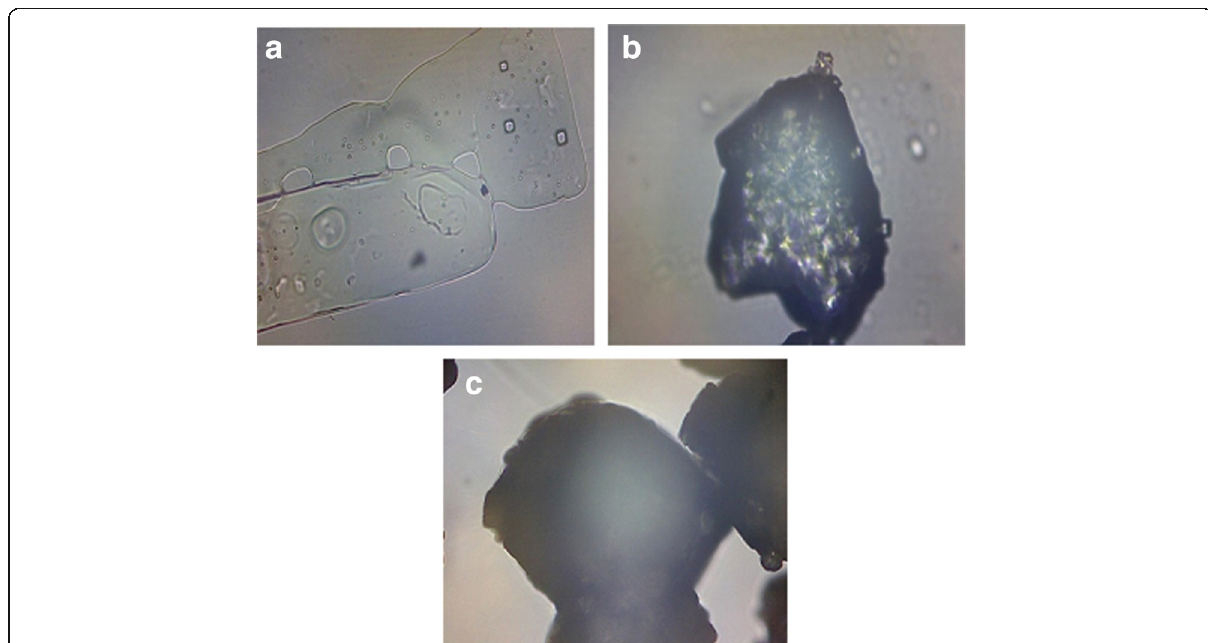
Fig. 1 Photomicrographs of a Uncoated KCl b Composition C2 of KCl coated with 6% Eudragit E 100 solution c Composition C3 of KCl coated with 10% Eudragit E 100